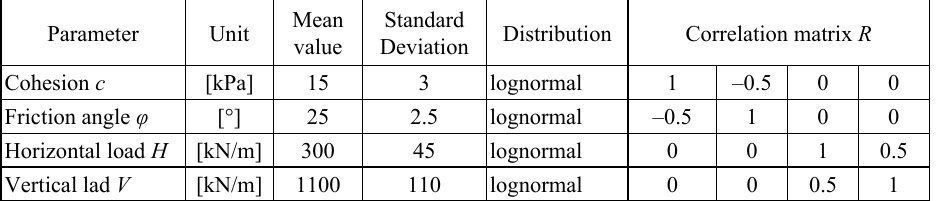
Table 2. Probabilistic characteristics assumed in Example 1